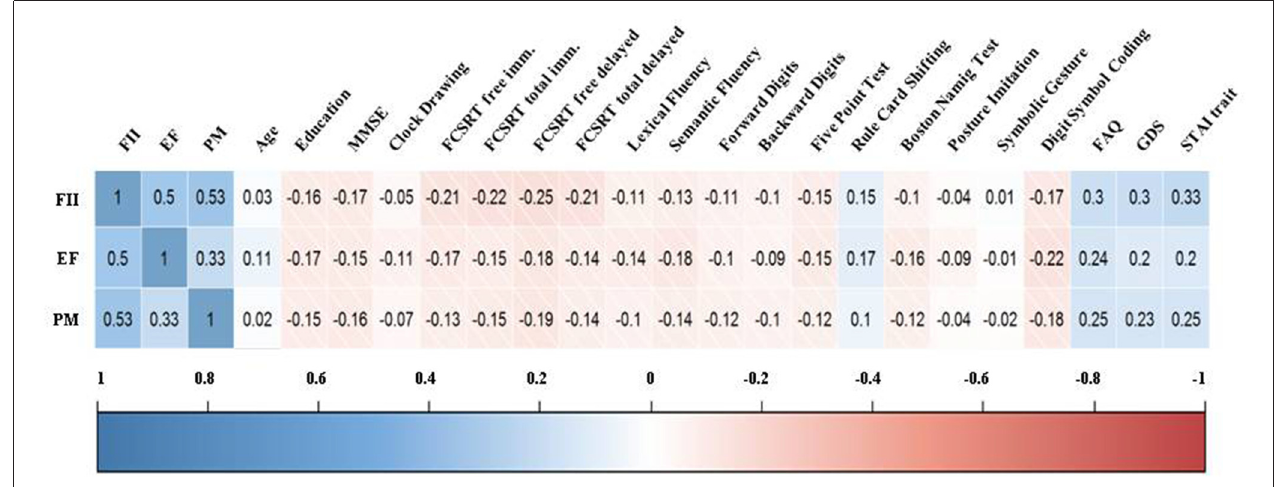
FIGURE 1 | Correlogram between the factors of the everyday memory questionnaire (EMQ) and demographic and cognitive variables. Note. FII, Forgetfulness of Immediate Information; EF, Executive Functions; PM, Prospective Memory; MMSE, Mini-Mental State Examination; FCSRT, Free and Cued Selective Reminding Test; FAQ, Functional Activities Questionnaire; GDS, Geriatric Depression Scale; STAI, State-Trait Anxiety Inventory.